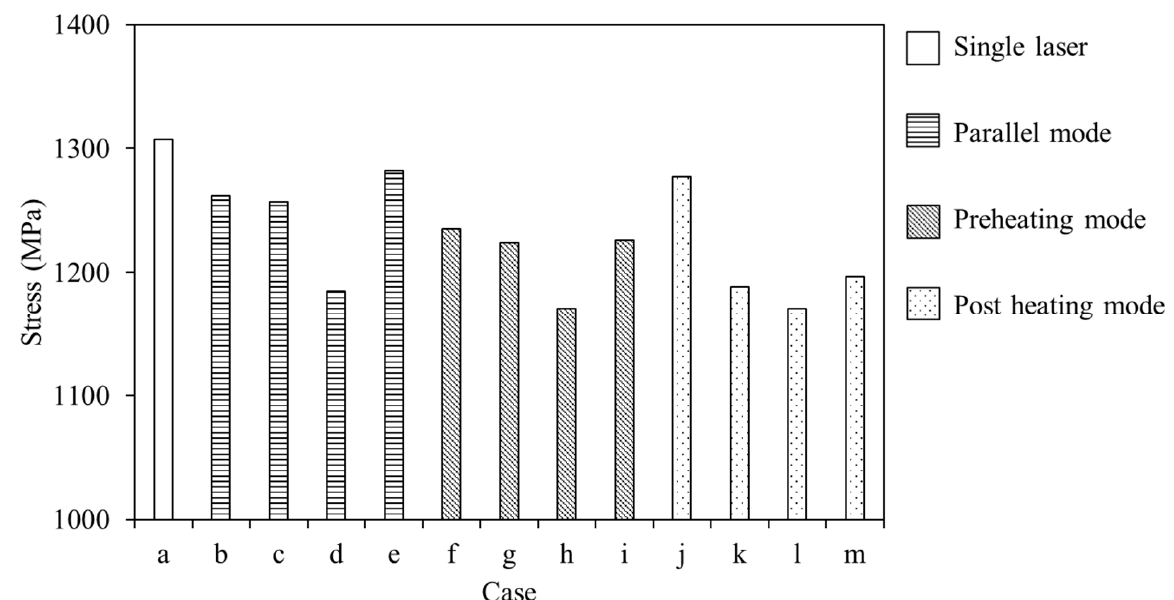
Figure 10. The peak residual stress for different scanning modes and process parameters: ( a ) single laser beam; ( b )–( e ) parallel model; ( f )–( i ) preheating mode; and ( j )–( m ) post ‐ heating mode.